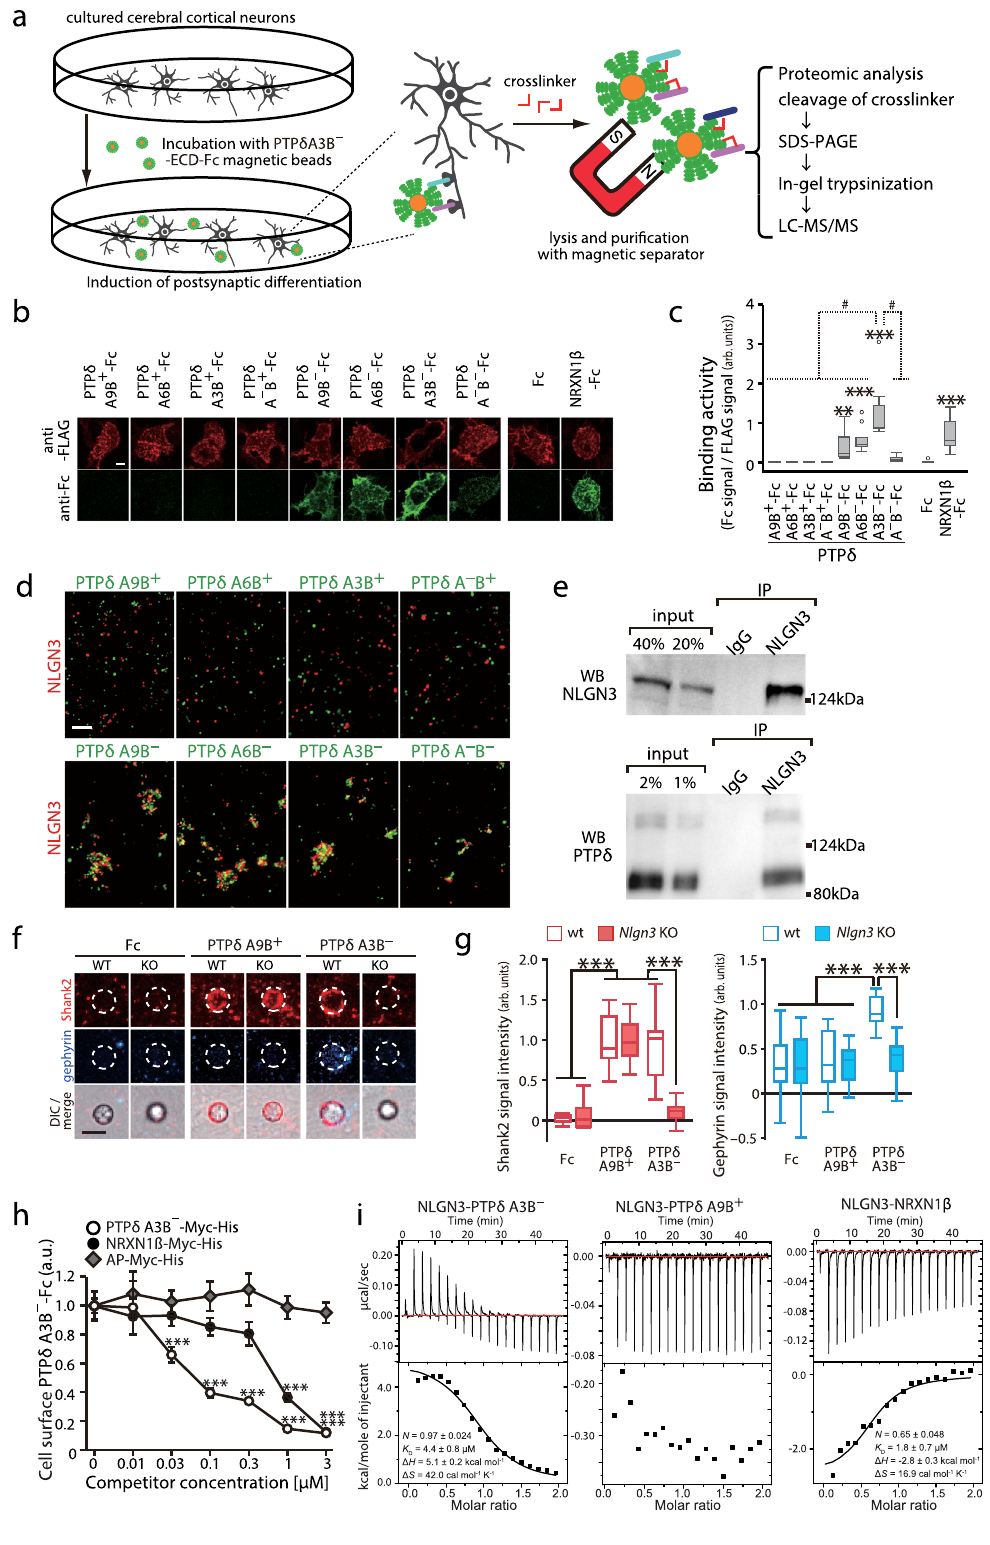
the apo-NLGN3 crystal contains two NLGN3 molecules, which form a dimer (Supplementary Fig. 4a). The molar mass of the recombinant mouse NLGN3 ECD determined by size-exclusion chromatography coupled with multiangle light scattering (SEC- MALS) analysis (Supplementary Fig. 4b) is 160 kDa, which cor- responds to the mouse NLGN3 ECD dimer. All reported NLGN